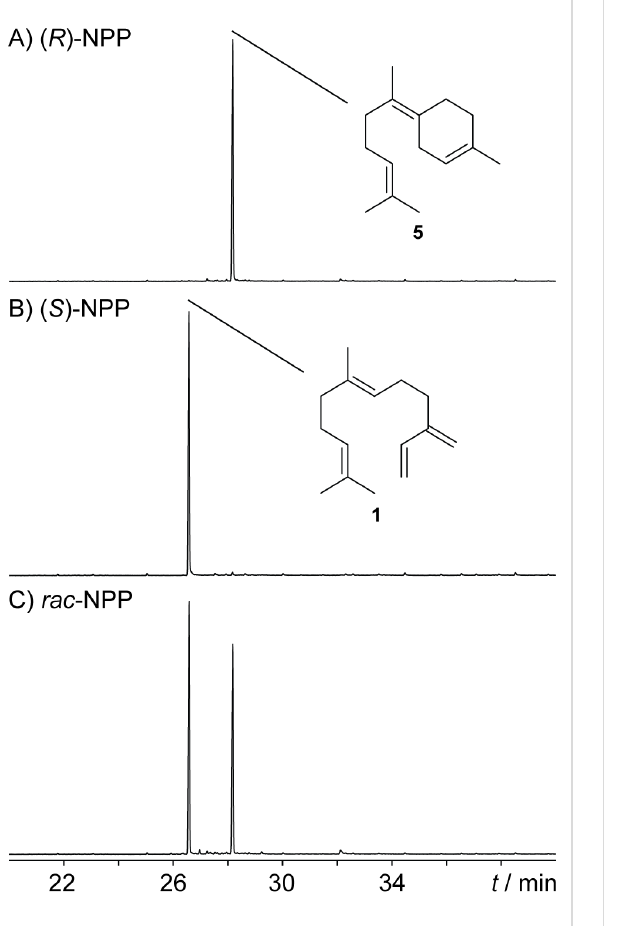
Figure 3: Total ion chromatograms of hexane extracts from incubation experiments with BbS and A) ( R )-NPP, B) ( S )-NPP and C) ( rac )-NPP.